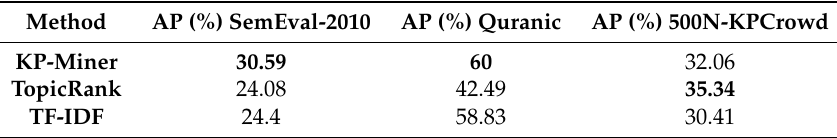
Table 5. Comparison in terms of Average Precision (AP).